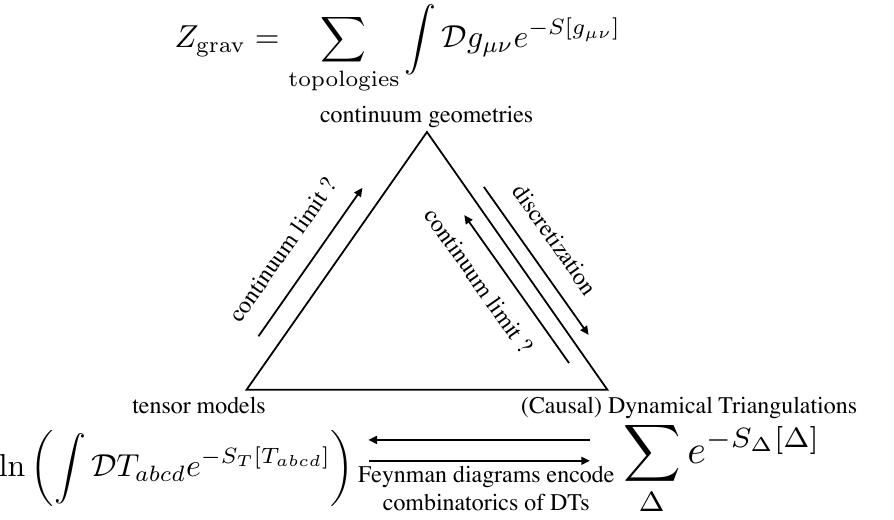
Figure 1 . We show the relation between the generating functional for quantum gravity in the continuum, dynamical triangulations and tensor